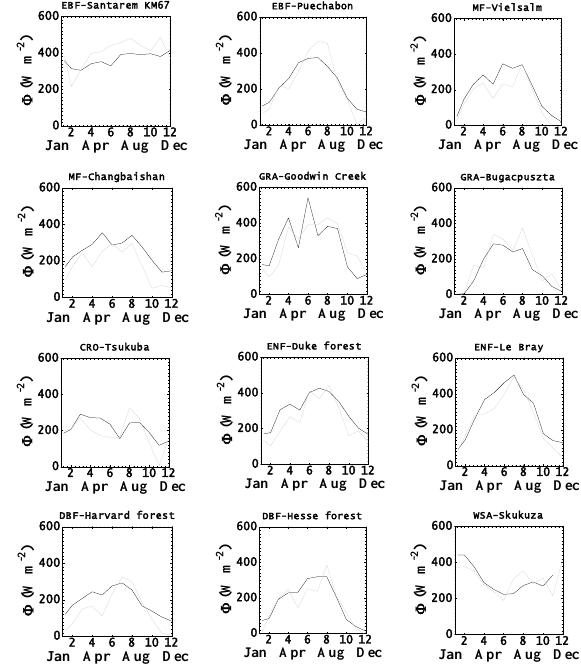
Figure 8. Satellite (grey) and tower (black) time series of monthly average 13:30LT net available energy (cid:56) [ (cid:56) = (H + λE ) (for the tower sites)] for a selection of sites for 2003. The numbers on the x axis are the month numbers, i.e. January is month number 1 and December is month number